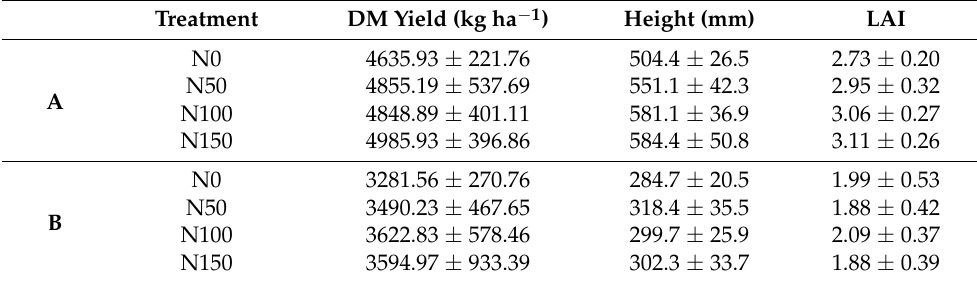
Table 2. Dry matter (DM) yield, height and leaf area of each treatment before ( A ) and at the end of experiment ( B ). (Mean ± SD, n = 3).